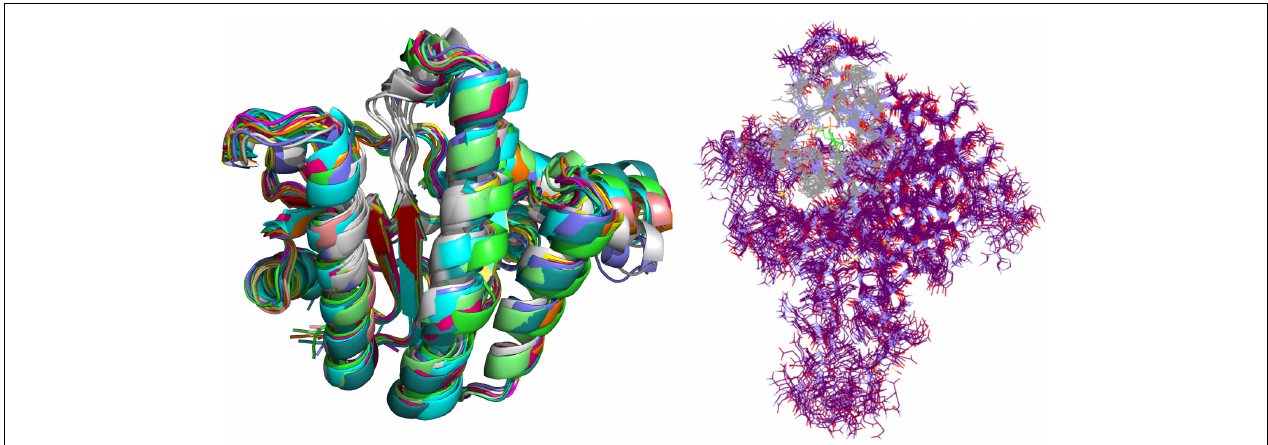
FIGURE 4 | Selected snapshots of E. coli UppS obtained with MD and ClusCo clustering. Individual chains are presented in ribbon model colored distinctly for every snapshot used in the ensemble docking experiment. In this manner, movement of the protein along the MD trajectory is emphasized and observed (left). Defined binding site for GOLD ensemble docking experiment in gray-colored line model representation; in green colored line representation there is the center residue of the defined binding site for docking experiment while the rest of the protein is depicted as purple colored line model (right).